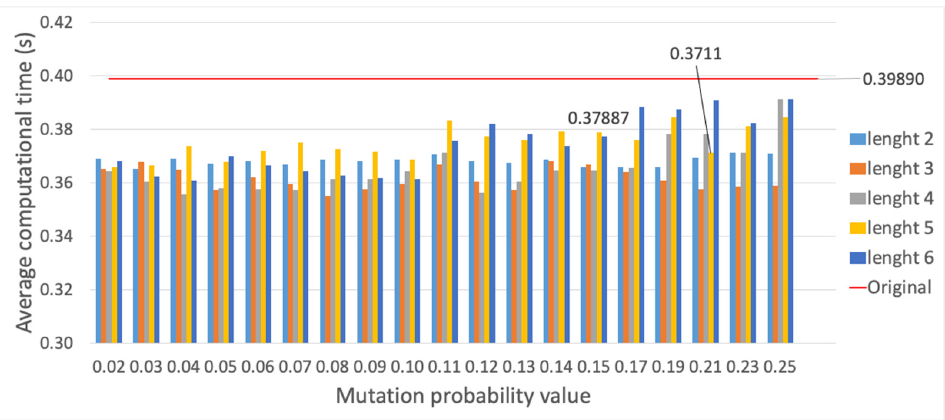
Figure 20. Average computational time (s) for RSM method vs. different mutation probability val- ues.